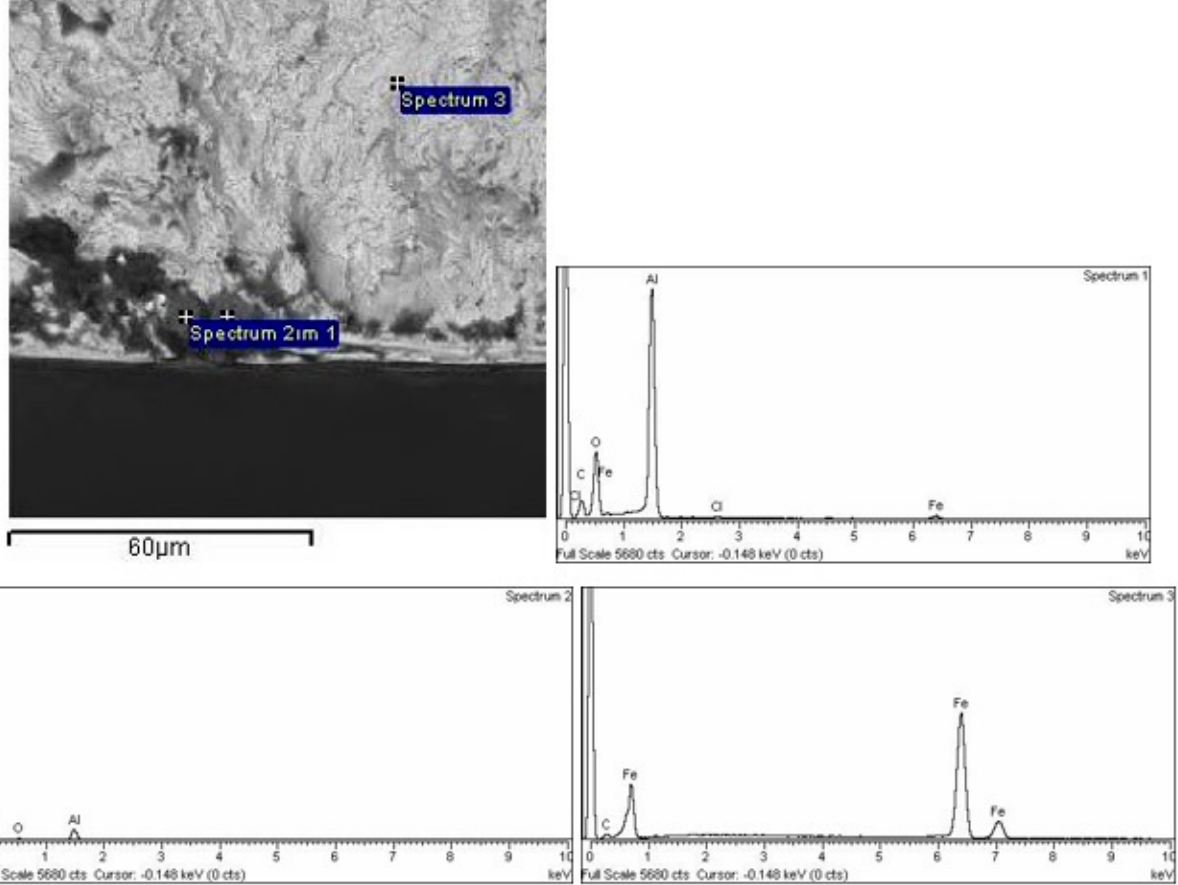
Table 7. Investigated materials: Load, testing, test results and possible damage.